Question: Name the type of graph shown.
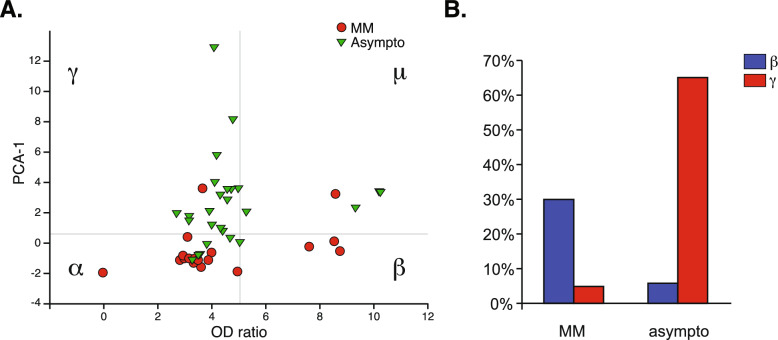
Answer: scatter